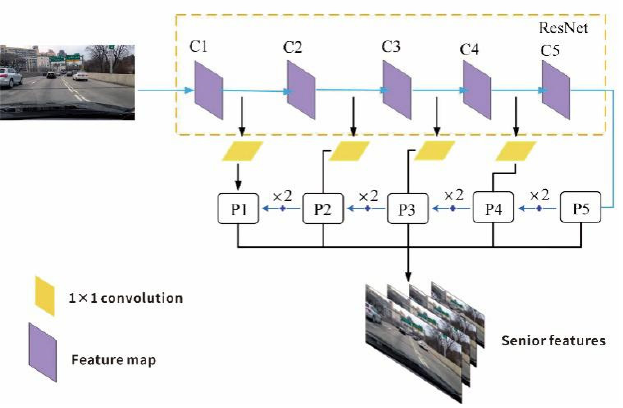
Figure 9. Advanced feature extraction.